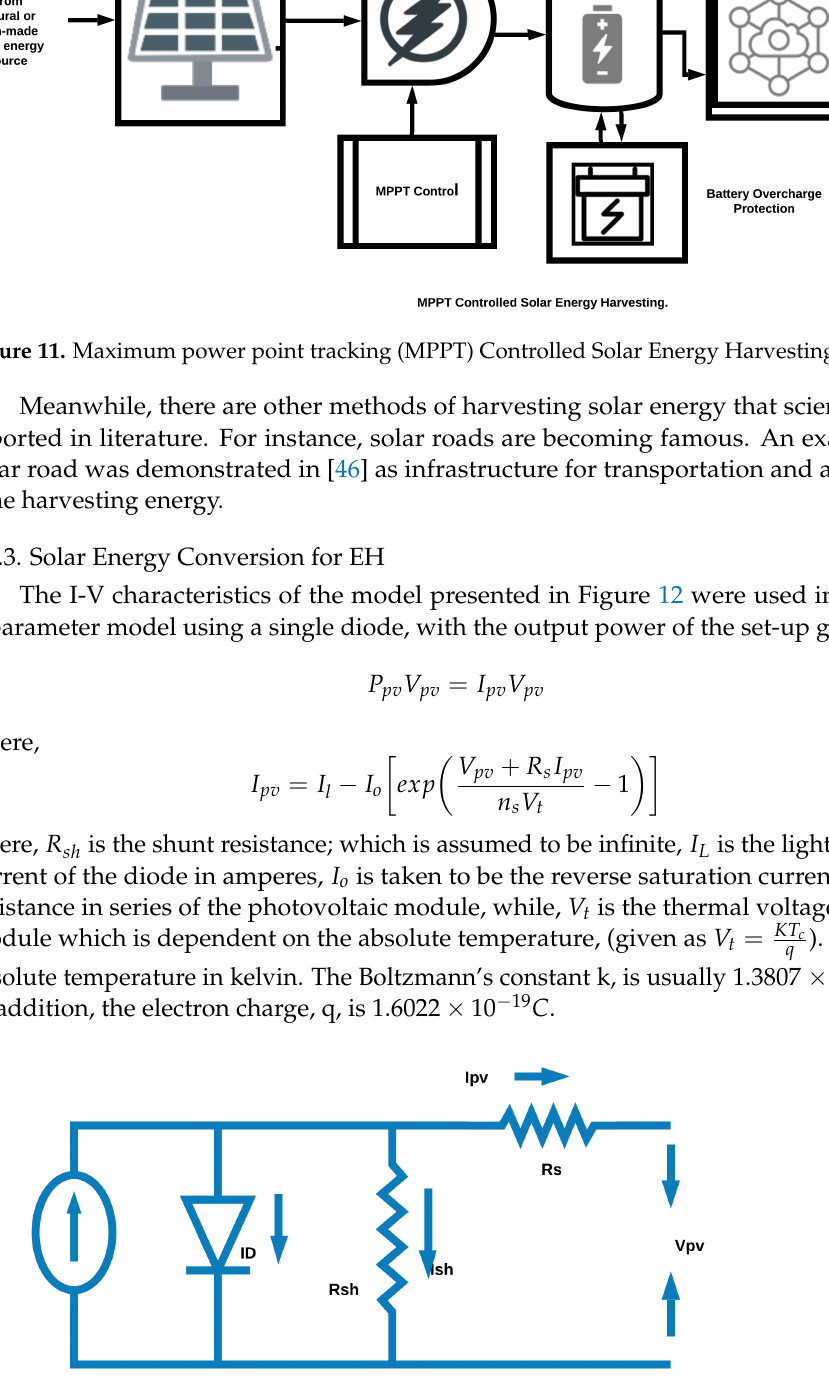
Figure 12. Photovoltaic (PV) Module Electrical Equivalent Circuit